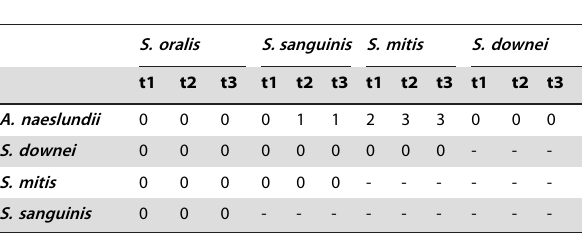
(Table 1), the organism was inoculated third. S. downei HG594 and S. sanguinis SK150 were the most acidogenic bacteria in planktonic